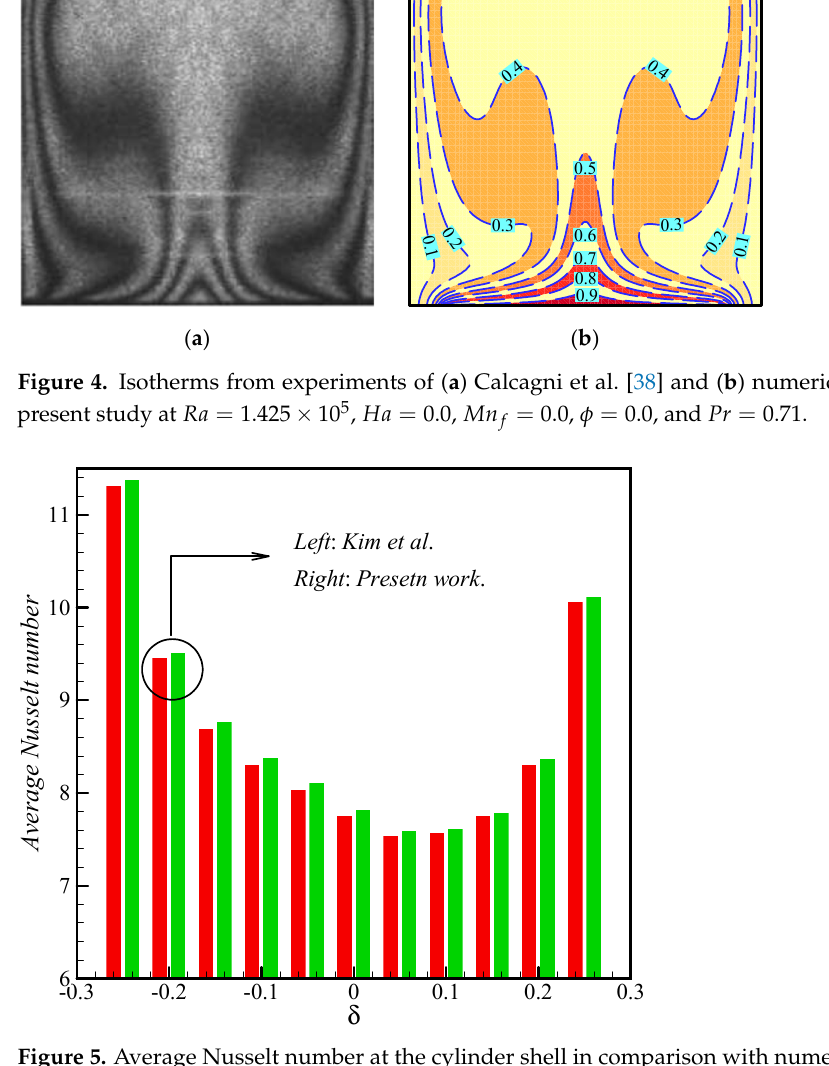
Figure 5. Average Nusselt number at the cylinder shell in comparison with numerical data of Kim et al. [39] for Ha = 0.0, Mn f = 0.0, φ = 0.0, and Pr = 0.7 .